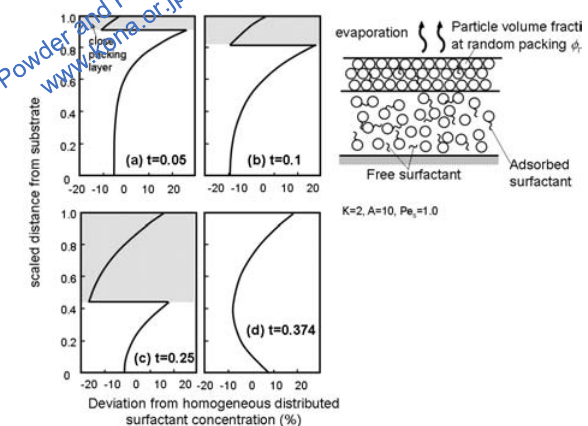
Fig. 6 Variations in surfactant distribution in shrinking suspension film 31)